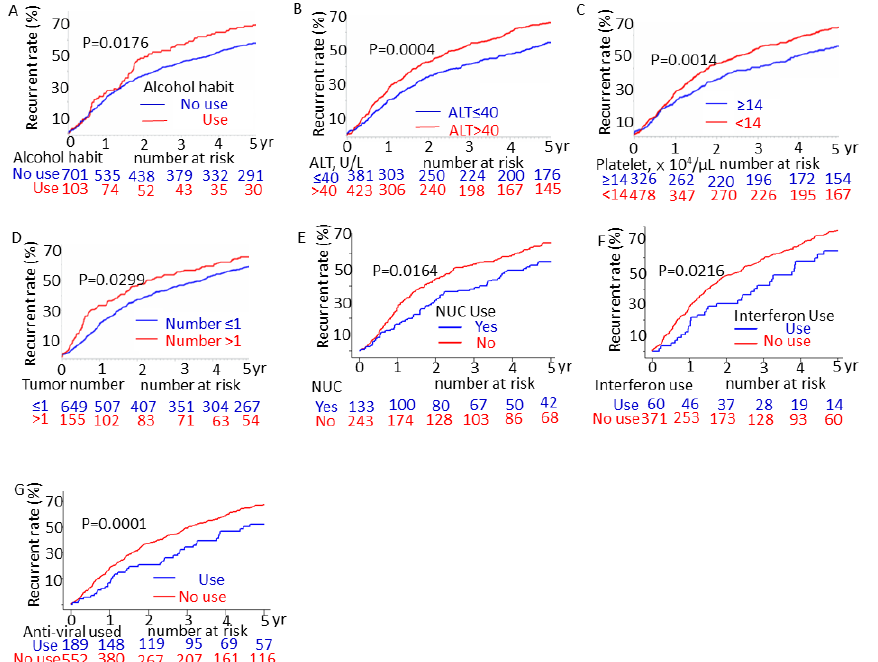
Figure 4. Univariate Cox regression analysis of the cumulative recurrence rates of early hepatocel- lular carcinoma (HCC) post-primary curative therapy ( p values determined by the log-rank test): ( A ) alcohol habits, ( B ) alanine aminotransferase (ALT) level, ( C ) platelet count, ( D ) tumor number, ( E ) patients with hepatitis B virus (HBV) infection with and without nucleoside analog (NUC) treat- ment, and ( F ) patients with hepatitis C virus (HCV) infection with and without interferon treatment, ( G ) patients with and without antiviral treatments (nucleoside analog (NUC)) or interferon.